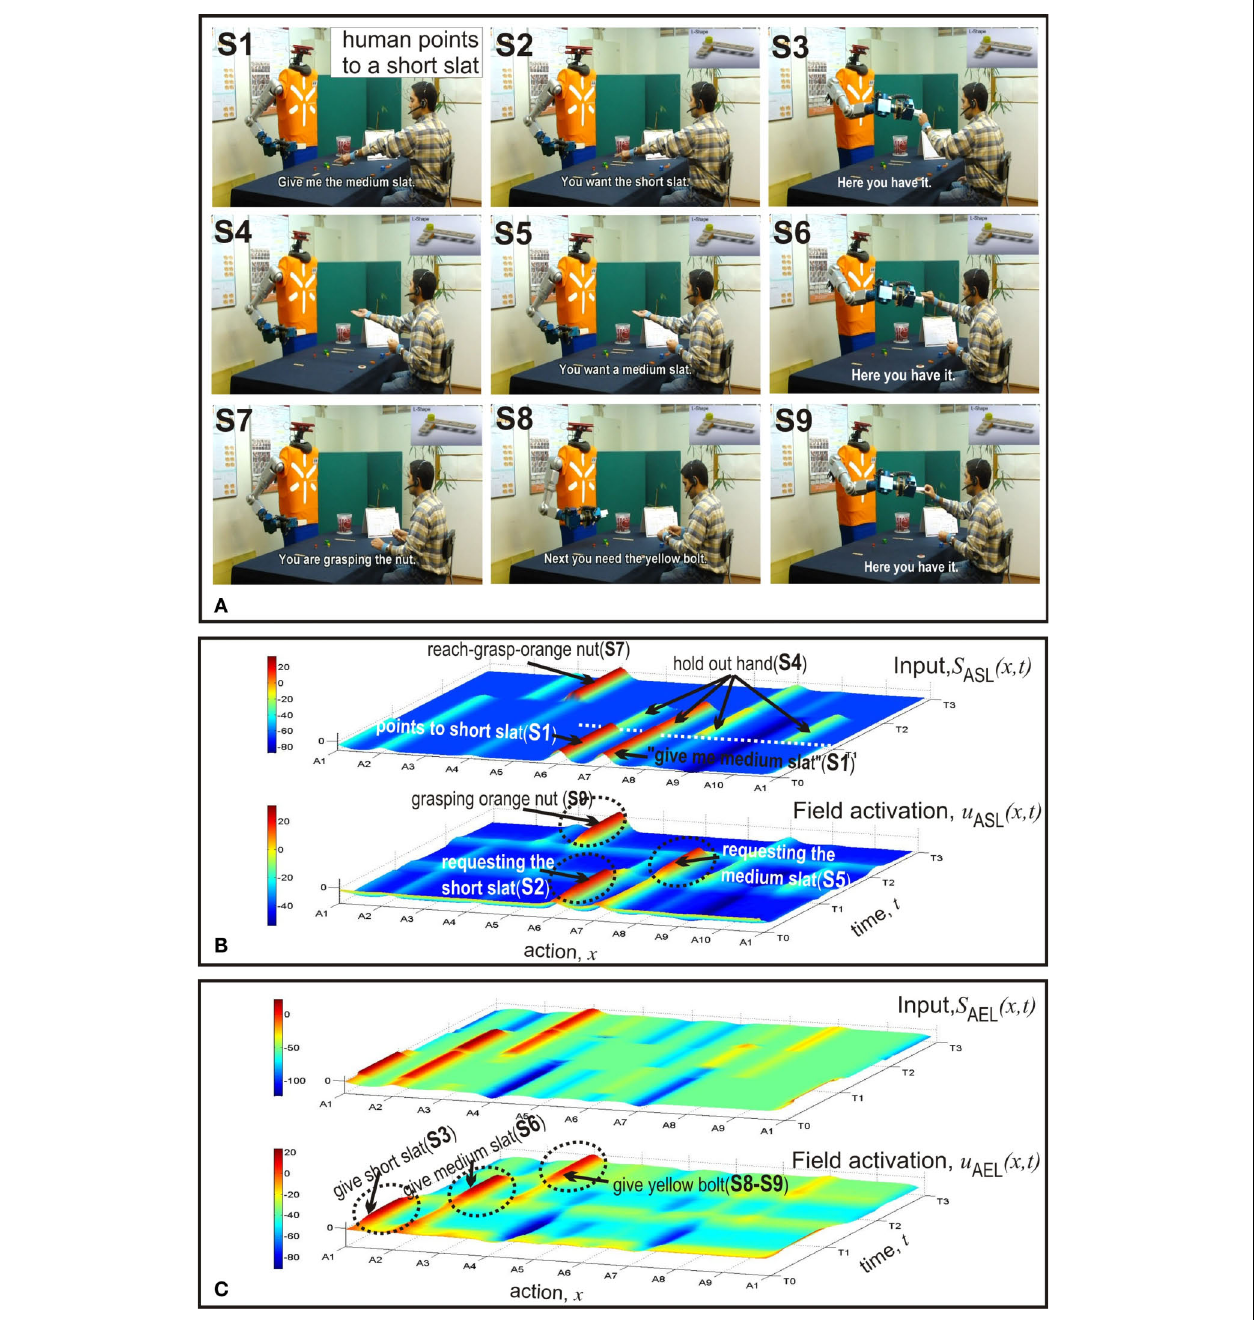
FIGURE 4 | First example: (1) goal inference when gesture and speech contain incongruent information (ASL), and (2) anticipatory action selection (AEL). (A) Video snapshots. (B) Temporal evolutions of input to ASL (top) and activity in ASL (bottom). (C) Temporal evolutions of input to AEL (top) and activity in AEL